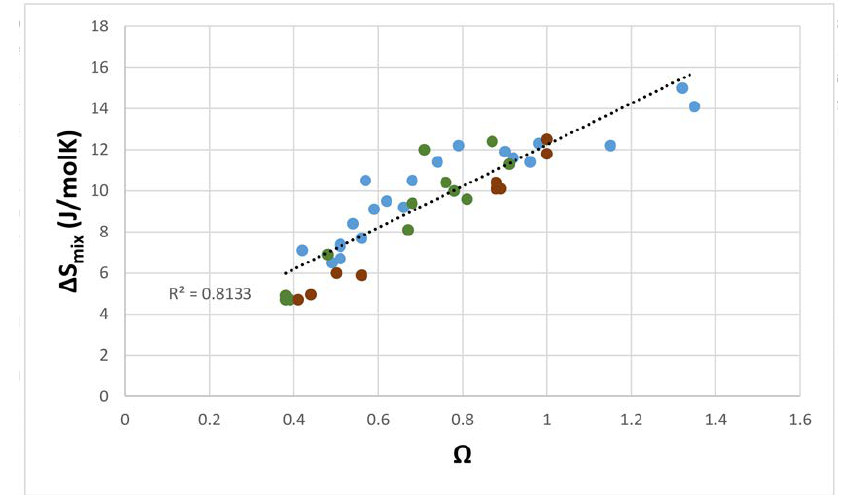
Figure 1. ∆ S mix versus Ω of eutectics with Nb ss and Nb 5 Si 3 in Nb-silicide based alloys, all data R 2 = 0.8133, eutectics with only Sn (filled green circles) R 2 = 0.8754, eutectics with only Ge (filled brown circles) R 2 = 0.9863.